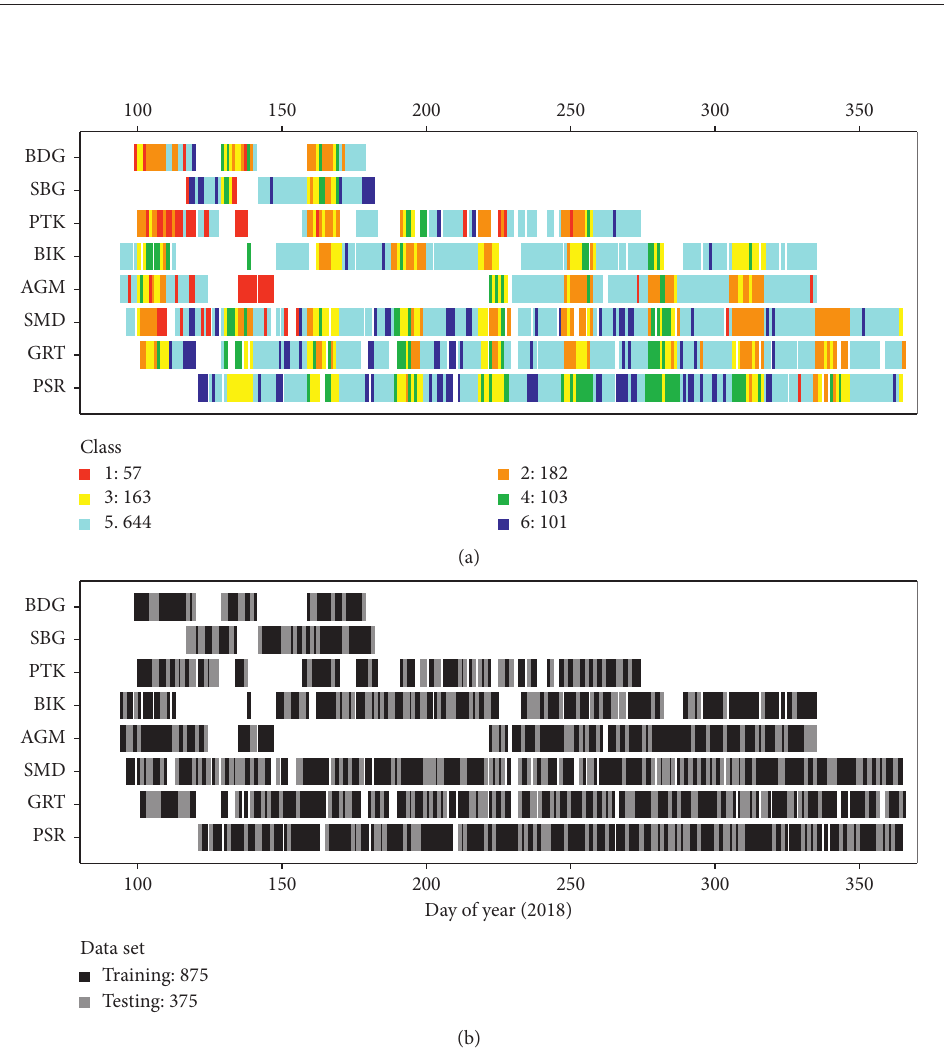
Figure 2: Distribution of classes and training/testing dataset.